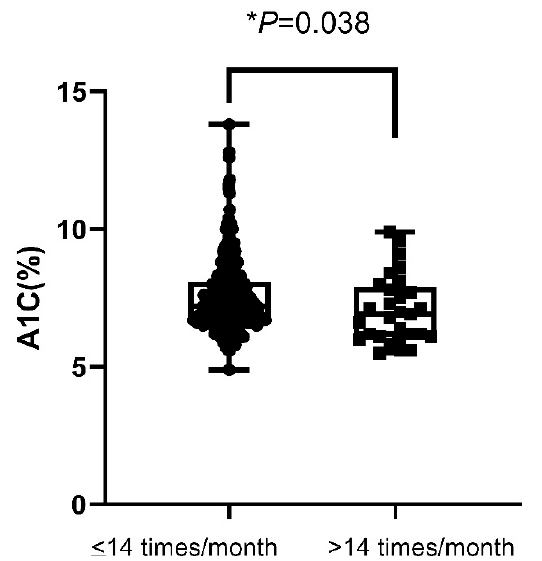
Figure 2. A1C value in non-insulin-treated patients according to the frequency of SMBG ( ≤ 14 or >14 measurements a month). A1C—hemoglobin A1C; SMBG—self-monitoring of blood glucose. * p <